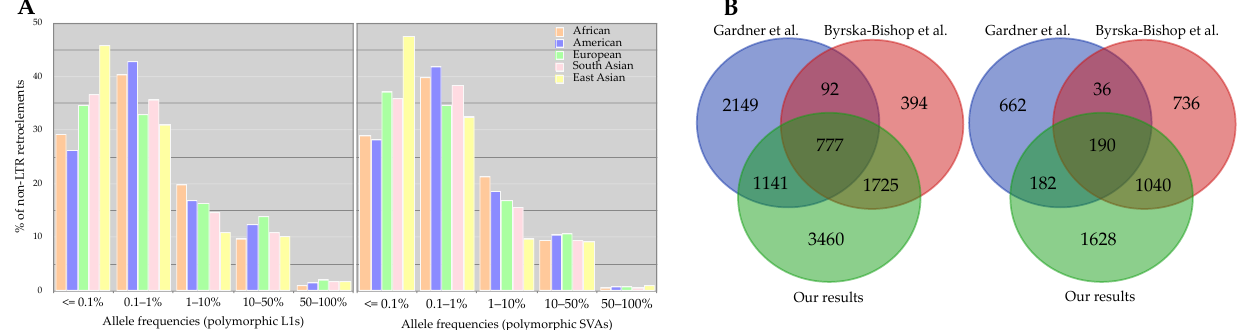
Figure 3. ( A ) Allele frequency distribution of polymorphic L1s and SVAs per continental population. ( B ) The comparison of discovered polymorphic loci in this study and the previous studies. The dataset used in our analysis and Byrska-Bishop et al.’s work was the same, whereas Gardner et al. studied the low-coverage samples (n =